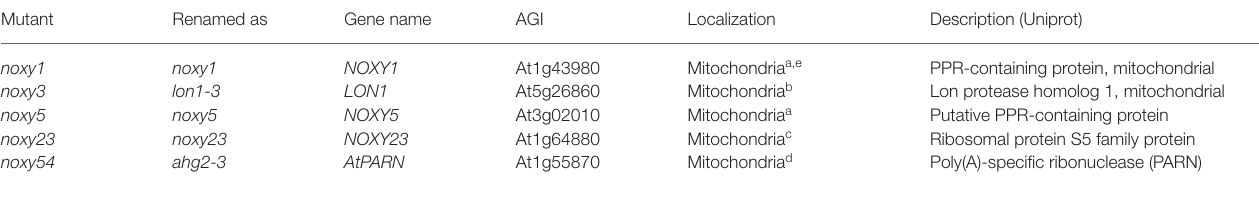
TABLE 1 | Mutants used in this study. Mutant Renamed as Gene name AGI Localization Description